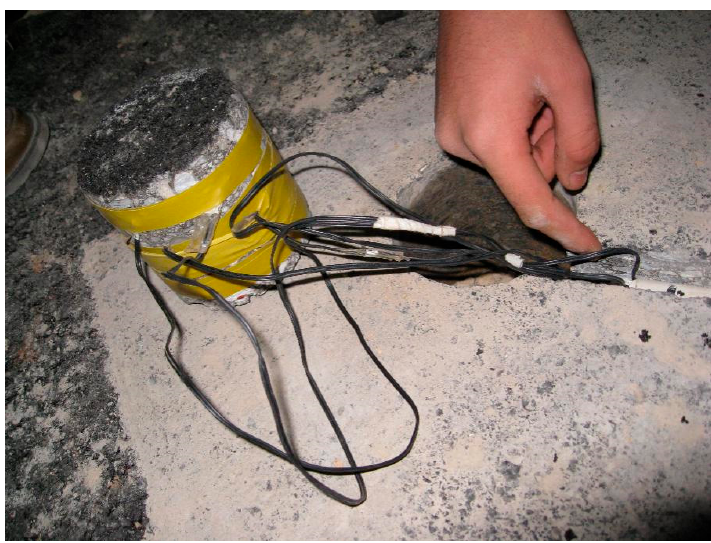
Figure 4. Burial of temperature sensor in the field.